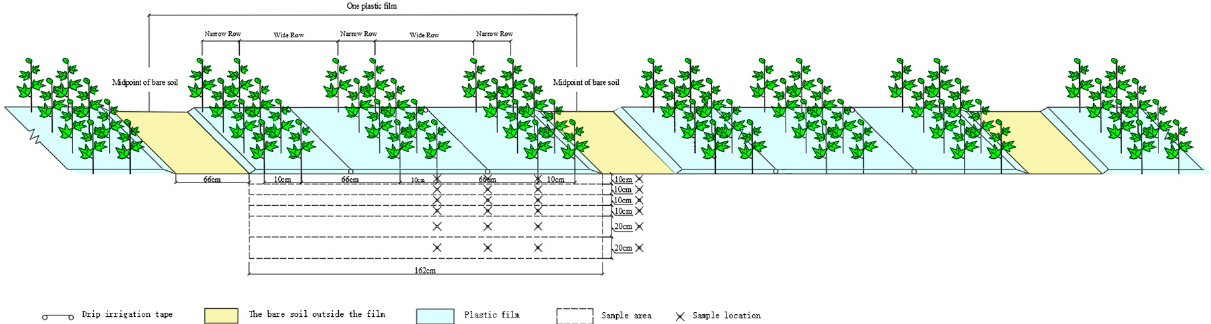
Figure 1. Planting pattern of drip-irrigated cotton with film mulching and depth of soil sampling. Spring irrigation amount of 1800 m 3 /ha was carried out on 8 April 2020 and 7 April 2021. Cotton seeds were sown on 16 April 2020 and 14 April 2021. The chemical topping was conducted on 18 tember 2021. The yield test was carried out on 10 October in both seasons, and the sampling range for the yield test was 2.18 m × 2.98 m (15% hectare), which was repeated three times.